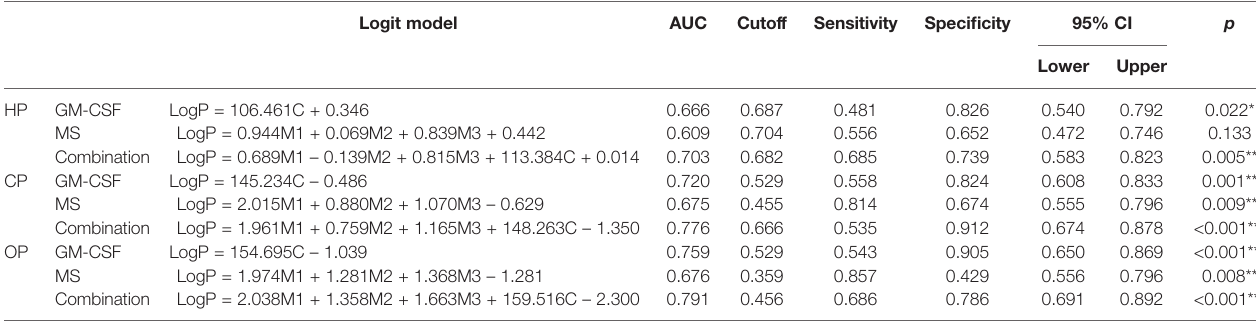
TABLE 4 | Receiver operating characteristic curve analyses among different groups.